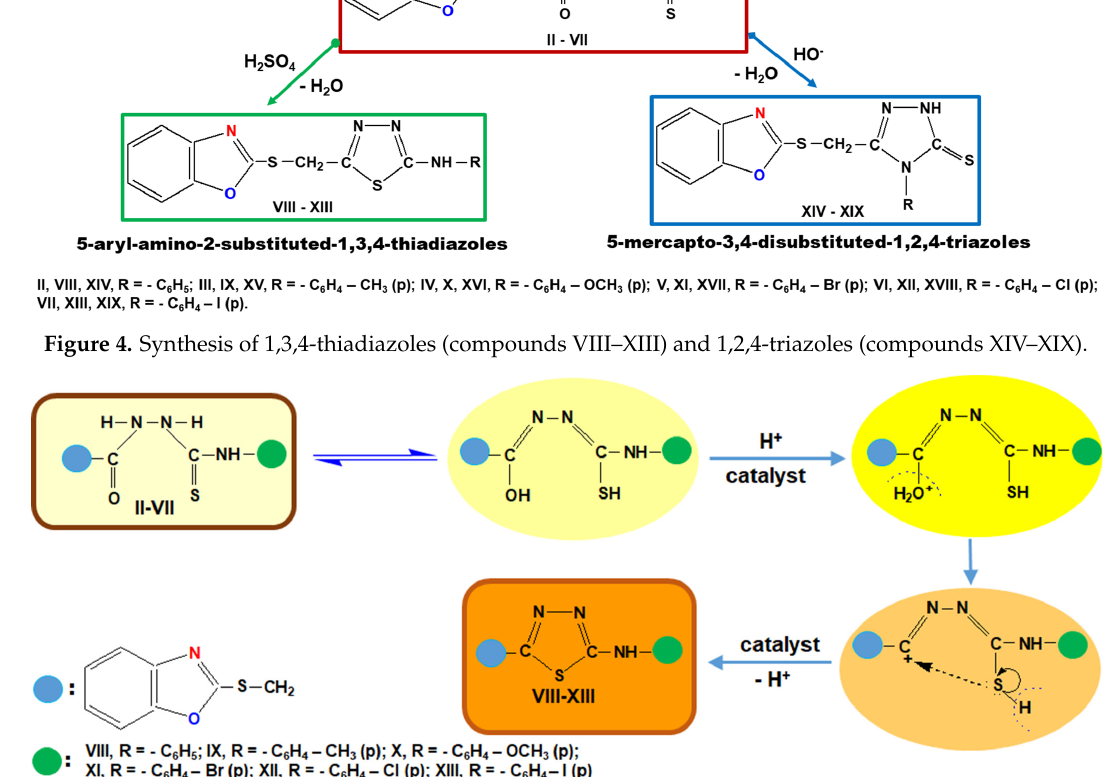
Figure 4. Synthesis of 1,3,4-thiadiazoles (compounds VIII–XIII) and 1,2,4-triazoles (compounds XIV–XIX).